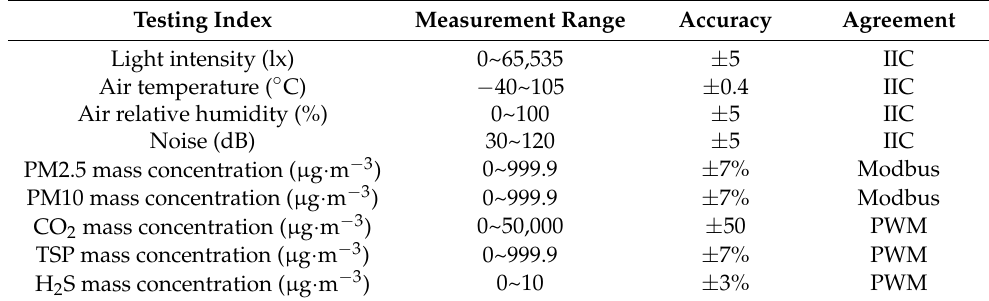
Table 1. Technical parameters of sensors.